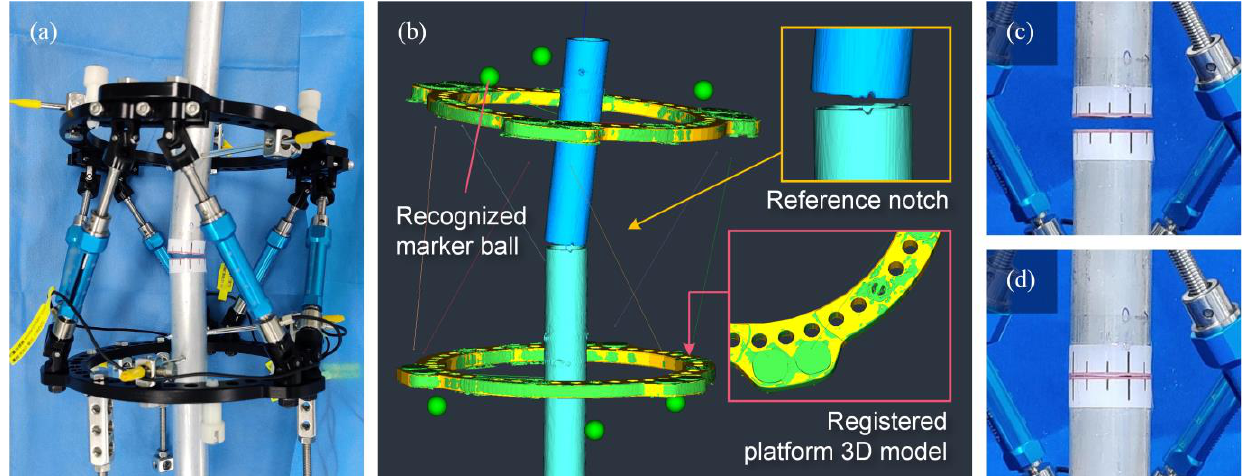
Figure 8. ( a ) Initial state of the 6-SPS mechanism fixing a fracture model. ( b ) 3D reconstruction models and registered standard models. ( c ) Axially aligned state and ( d ) reduction complete state of the fracture model.